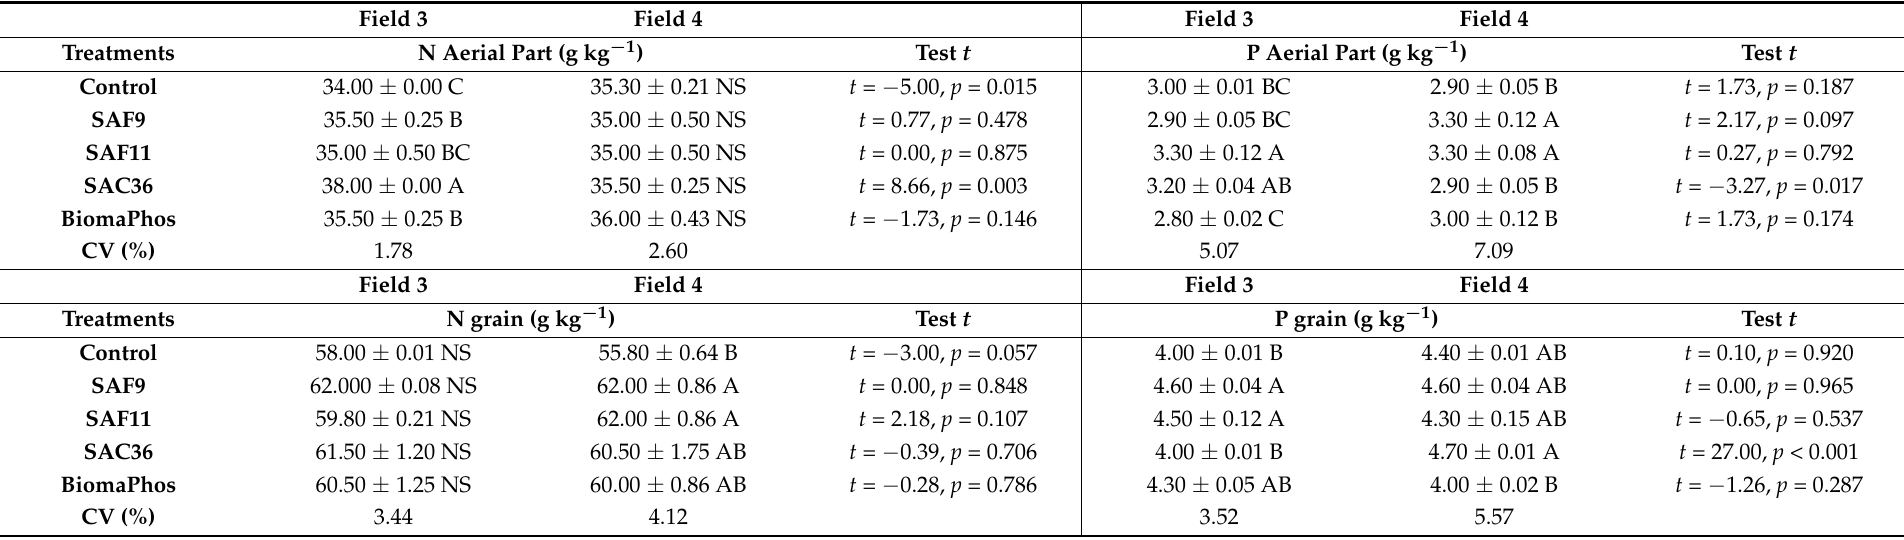
Table 6. Effect of inoculation with plant-growth-promoting rhizobacteria on N and P levels in the aerial part and grains of Glycine max L. plants grown in the summer 2020/2021, in two experimental fields of soybean cultivation, in the interior of the state of Goi á s, Brazil, with different histories of soybean cultivation: Field 3, soybean production for 10 years and Field 4, second year of soybean